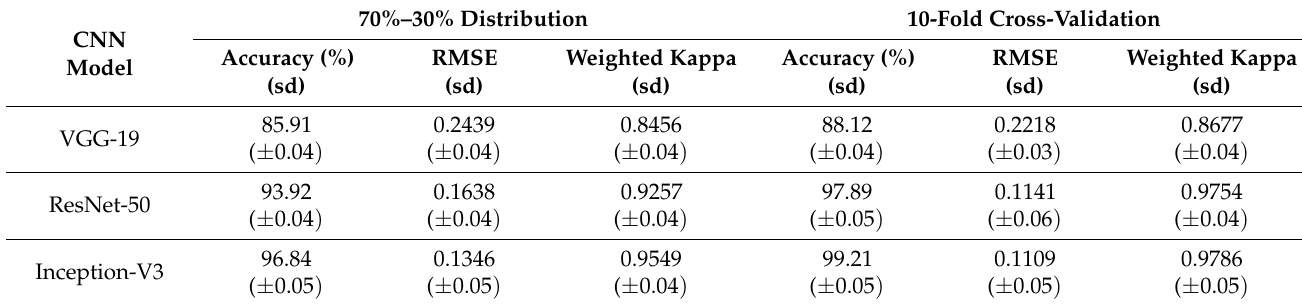
Table 2. Comparison of CNN models using dataset 2 for 40 epochs.